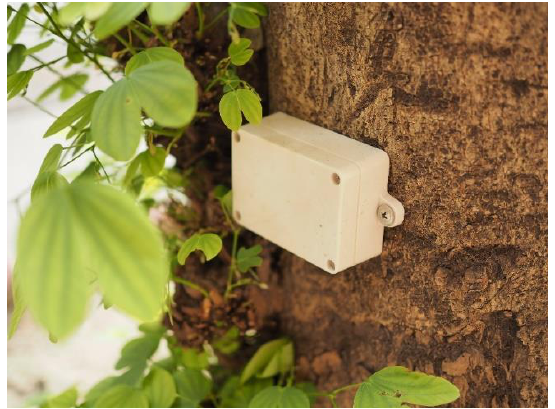
Figure 7. A prototype of a smart sensing technology (SST) sensor. It integrates high-precision accelerometers, geomagnetic sensors, and high-performance microprocessors to measure tree tit in the urban areas of Hong Kong.